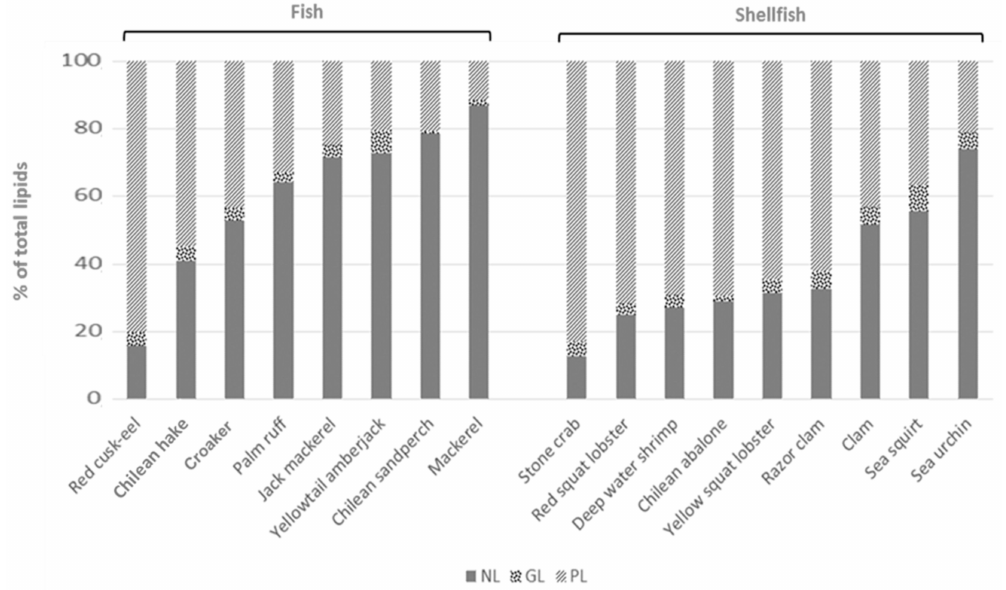
Figure 1. Proportions of lipid classes in total extracted lipids from fishes and shellfishes. NL: neutral lipids; GL: glycolipids; PL: